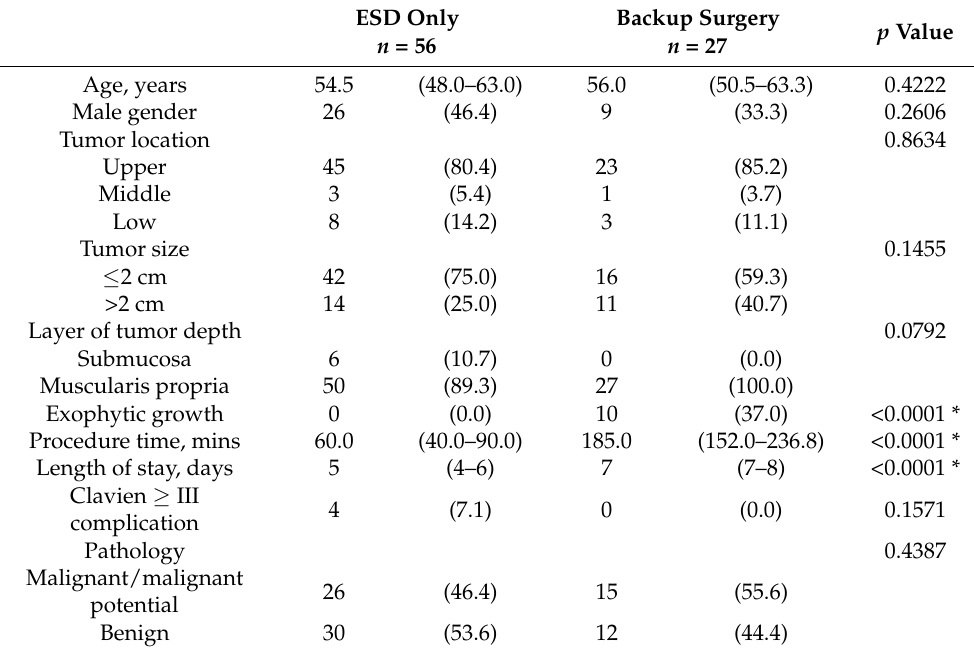
Table 1. Patient characteristics and peri-procedure